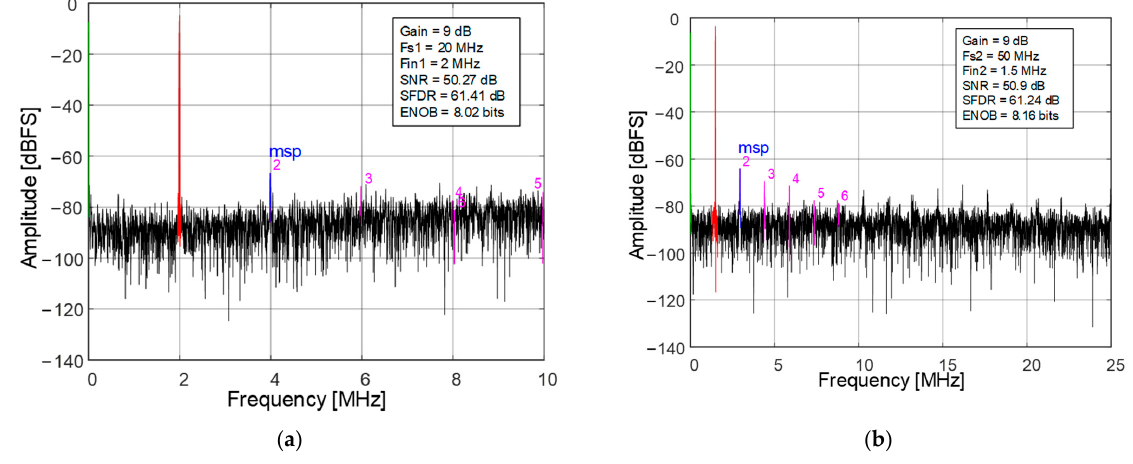
Figure 12. Measured spectrum for low-frequency input at 9 dB gain at: ( a ) 20 MS/s; ( b ) 50 MS/s.